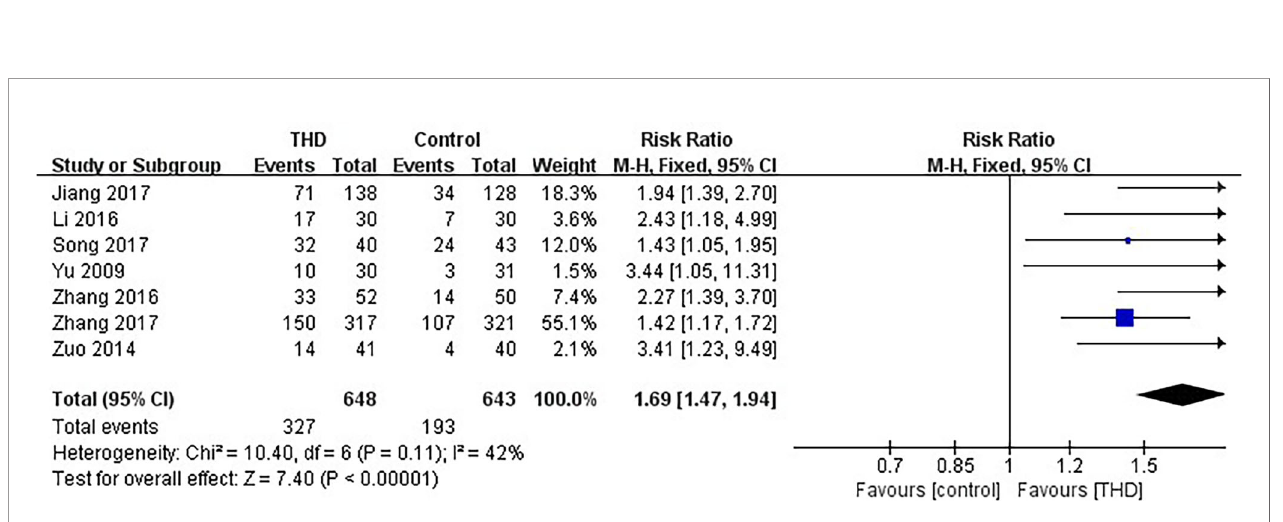
FIGURE 7 | Meta-analysis on no nausea (delayed phase).